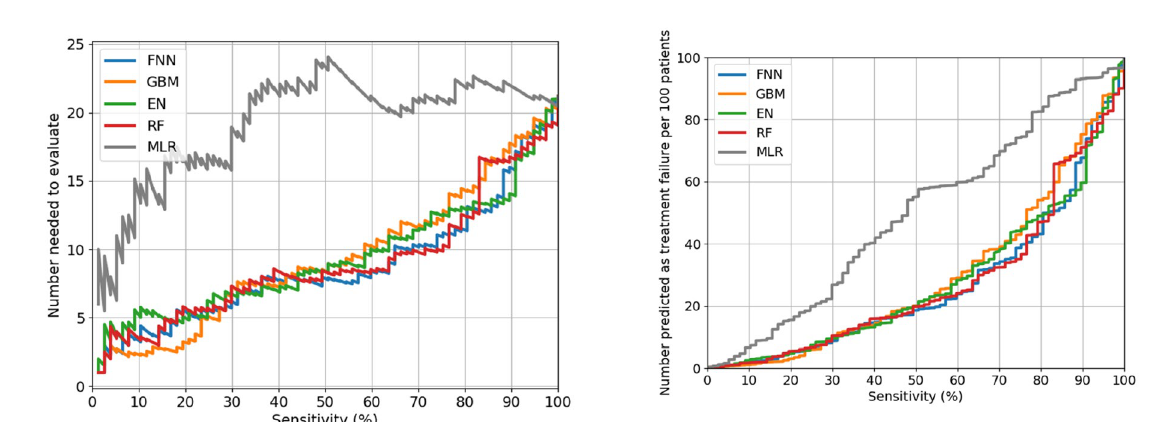
Figure 1. Prediction performance of 4 machine learning models vs. a multivariable logistic regression model. FNN feedforward neural network, EN elastic net, GBM gradient boosting machine, MLR multivariable logistic regression, RF random forest, ROC receiver operating characteristic. Data were derived using the validation sample, which comprised 1631 patients: 1554 with direct-acting antiviral treatment success, and 77 with treatment failure. ( A ), Results include C statistics and 95% CIs. ( B ), precision is equivalent to the positive predictive value, and recall to sensitivity). Models with curves closer to the upper right corner or above another curve have improved performance. ( C ), Number needed to evaluate by different cutoff points for sensitivity. ( D ), Alerts per 100 patients by various sensitivity cutoff